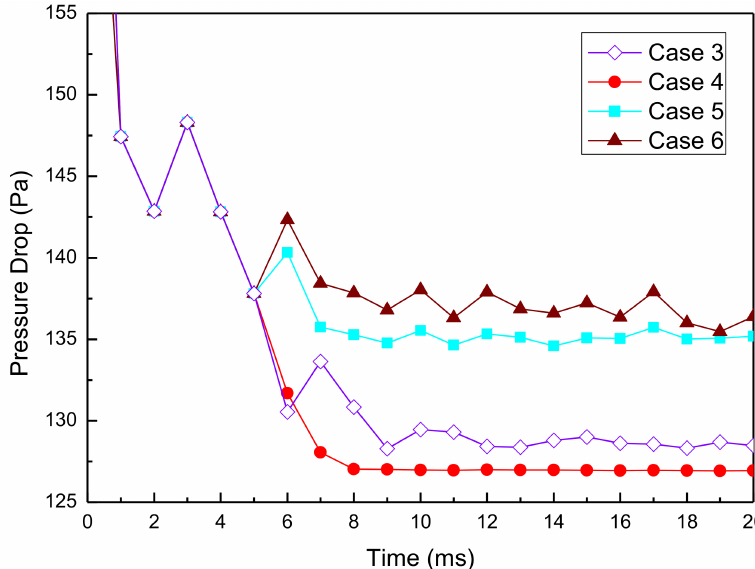
Figure 12. Pressure drop for the flow in the flow channel with various channel surface wettability for the cases given in Table